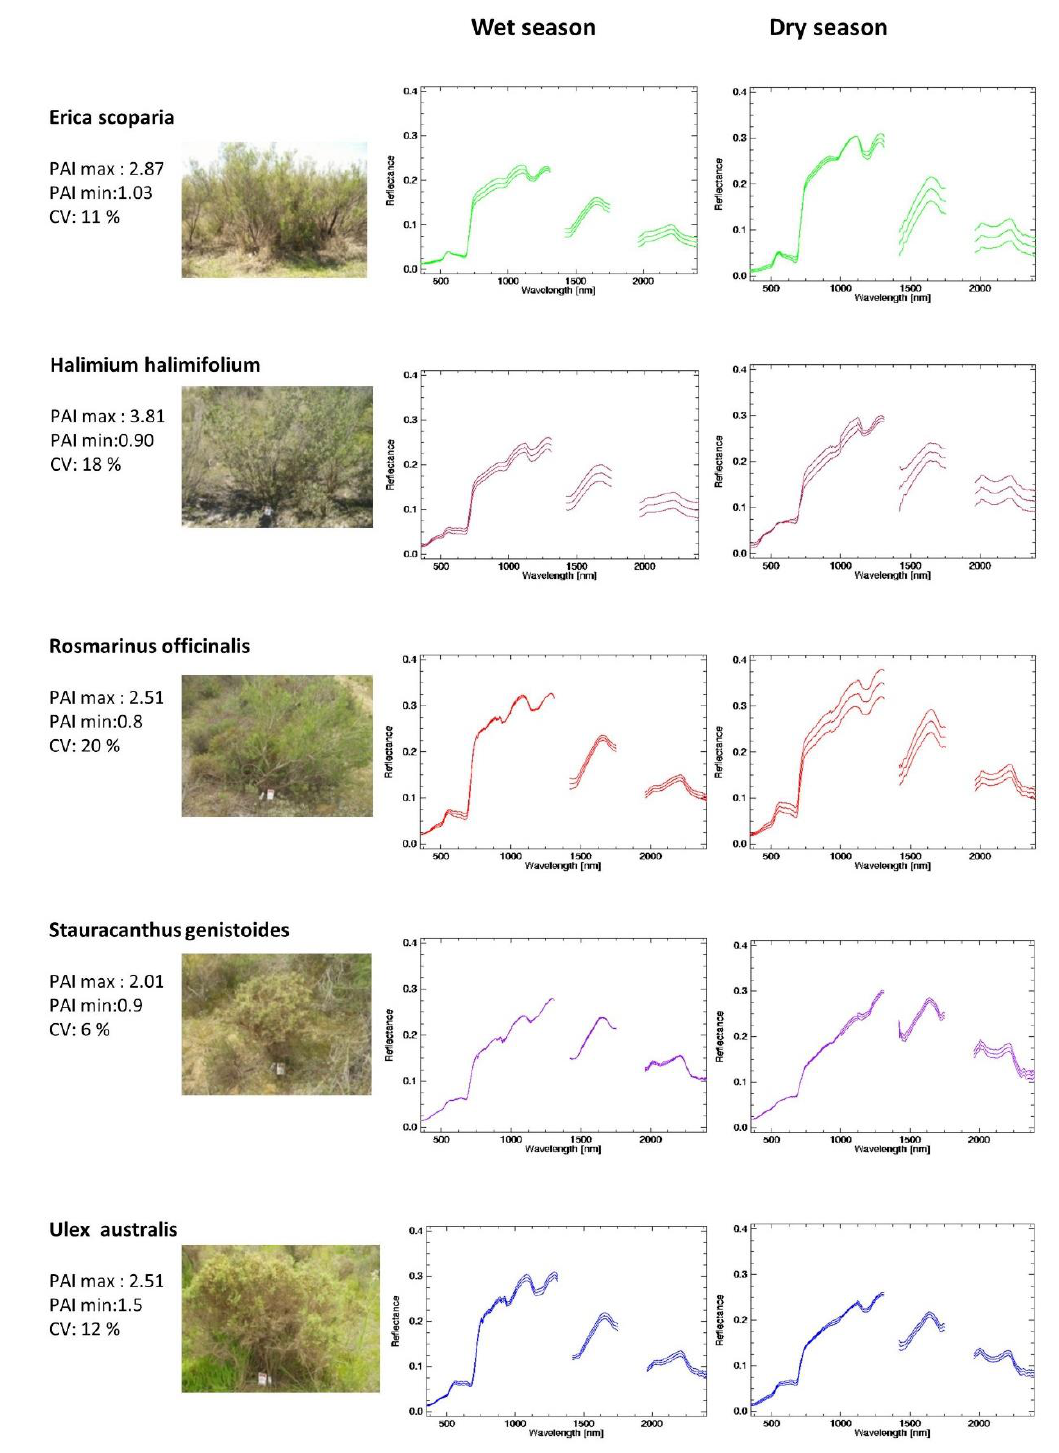
Figure 4. Spectral library of the five dominant shrub species in Doñana National Park. The graphics show the average and standard deviation spectral reflectance for dry and wet season. PAI and CV values are shown for every species spectral response in dry